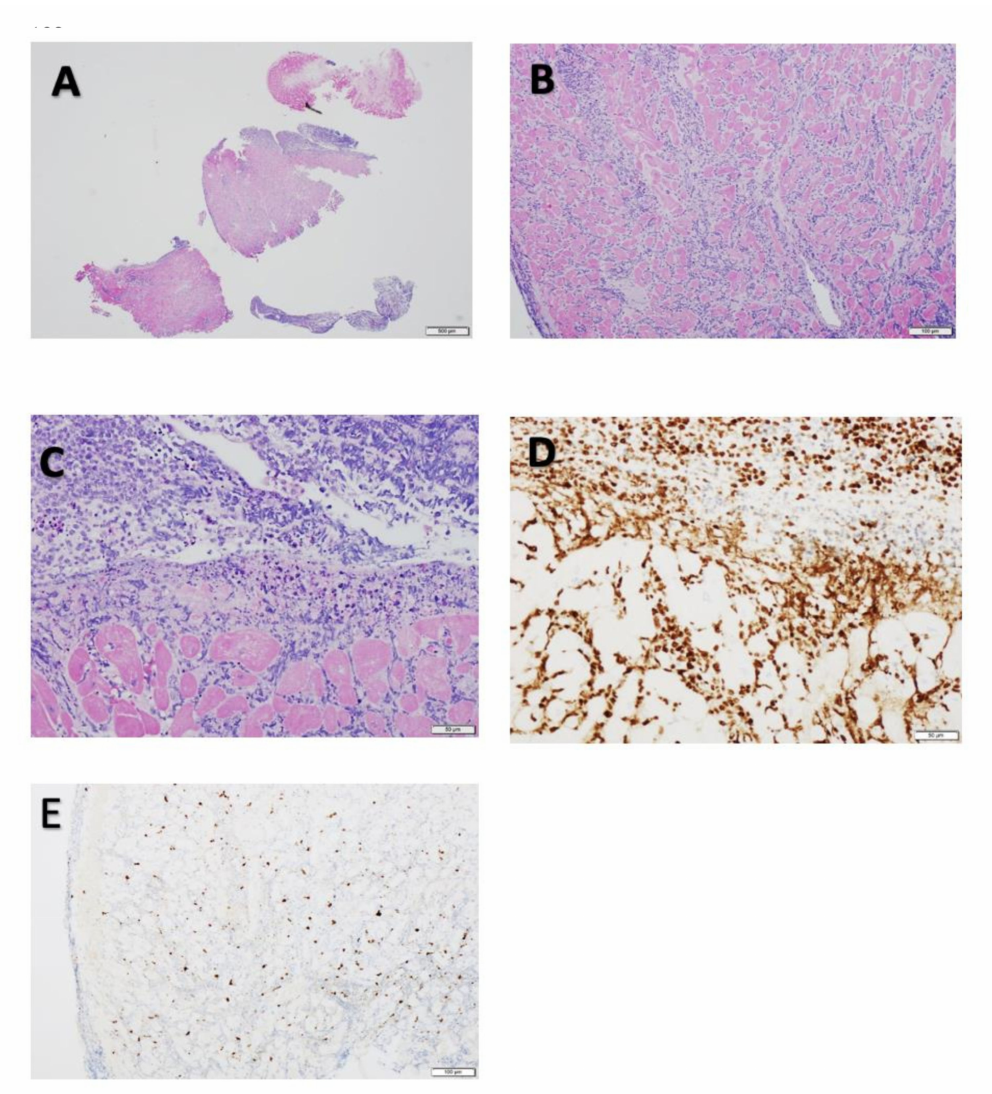
Figure 3. ( A ) Hematoxylin and eosin stain (low-power view, scale: 500 µ M ) showing dense lympho- cytic infiltrates involving every piece of the tissue biopsy sample and endocardium. ( B ) Hematoxylin and eosin stain of the dense lymphocytic infiltrates (midpower view, scale: 100 µ M). The infiltration is widespread around each myocyte. ( C ) Hematoxylin and eosin stain of the infiltrating cells (high- power view, scale: 50 µ M) showing highly malignant features, including numerous apoptotic bodies, frequent mitoses, and myocyte necrosis. ( D ) Immunohistochemical stain for PAX-5 demonstrating diffuse and strong positivity for the marker (higher-power view, scale: 50 µ M). ( E ) Immunohisto- chemical stain for TdT, a marker for diagnosis of acute leukemia. About 10% of the tumor cells were positive for TdT, supporting the diagnosis ALL. No features of sarcoidosis or amyloidosis are shown (midpower view, scale: 100 µ